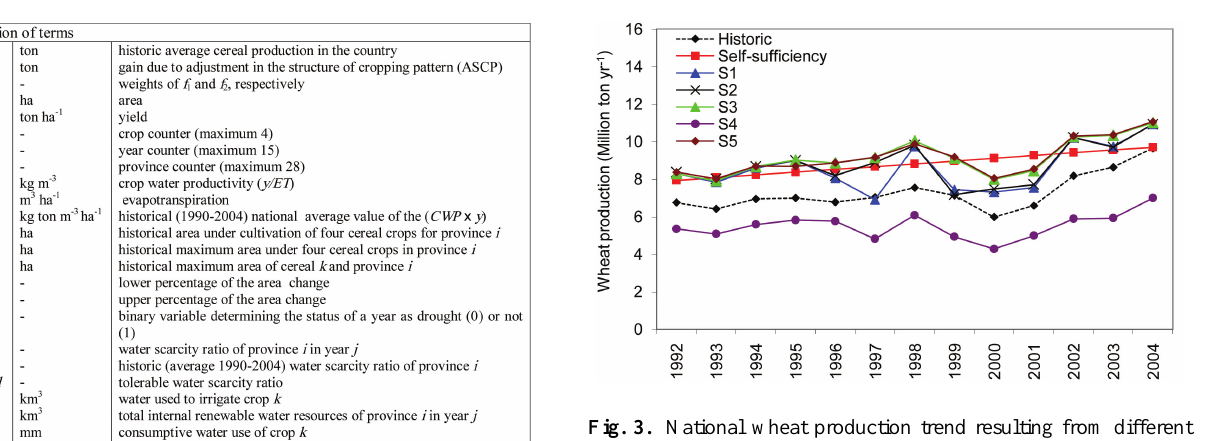
Fig. 3. National wheat production trend resulting from different water and food